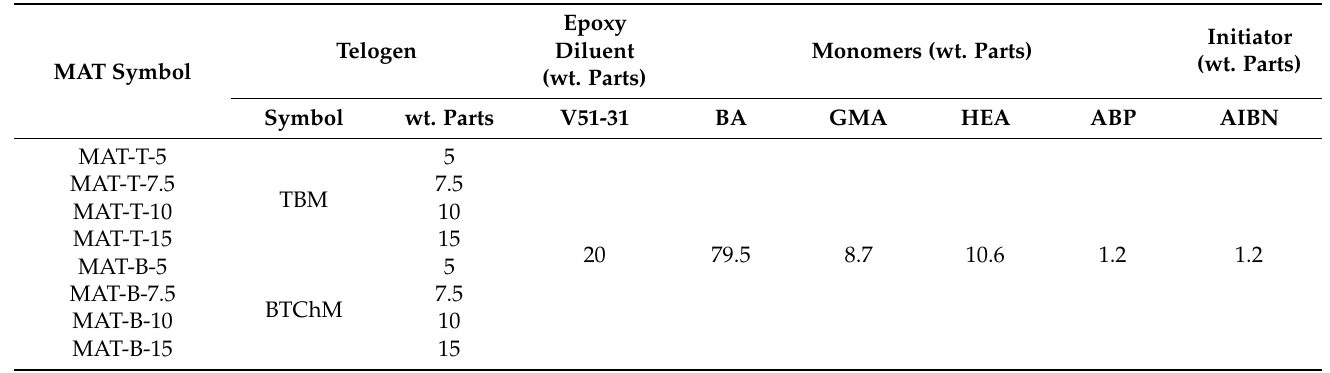
Table 1. Composition of multifunctional acrylate telomers